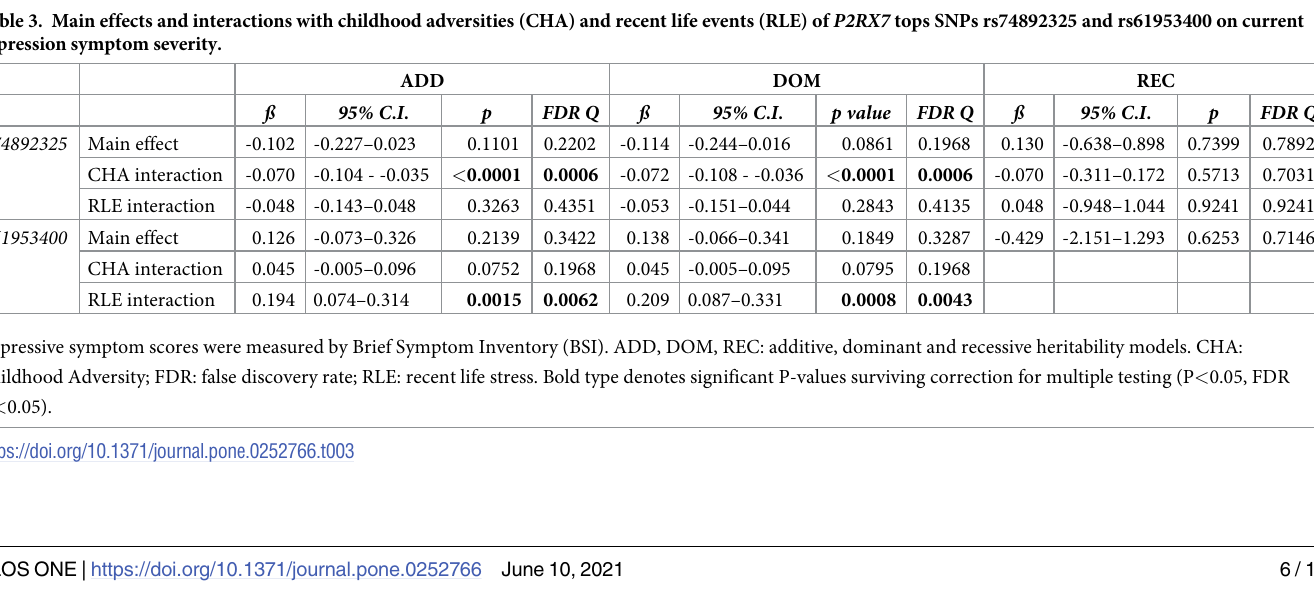
Both top P2X7R SNPs were in Hardy–Weinberg equilibrium in the sample (rs74892325: p = 0.8295, rs61953400: p = 0.5823). For rs74892325, T is the minor allele, with an allele fre- quency of 0.05771. For rs61953400, A is the minor allele, yielding an allele frequency of 0.0219. Both top SNPs were tested in main effect models as well as for interaction with both CHA and RLE (Table 3). None of the top SNPs had a significant main effect on BSI-depression. In case of rs74892325, no significant interaction effect emerged with recent life events (ADD: p = 0.3263, DOM: p = 0.2843, REC: p = 0.9241), but a significant interaction with child- hood adversity on current depressive symptoms was found in both additive (p < 0.0001) and dominant (p < 0.0001) but not in recessive (p = 0.5713) models which remained significant after correction for multiple testing (FDR Q = 0.0007 and FDR Q = 0.0007 for additive and dominant models respectively). Rs74892325 minor T allele carriers scored significantly lower on BSI-depression scale if they were exposed to moderate or severe childhood maltreatment reflecting a protective effect for the minor allele (Fig 2).